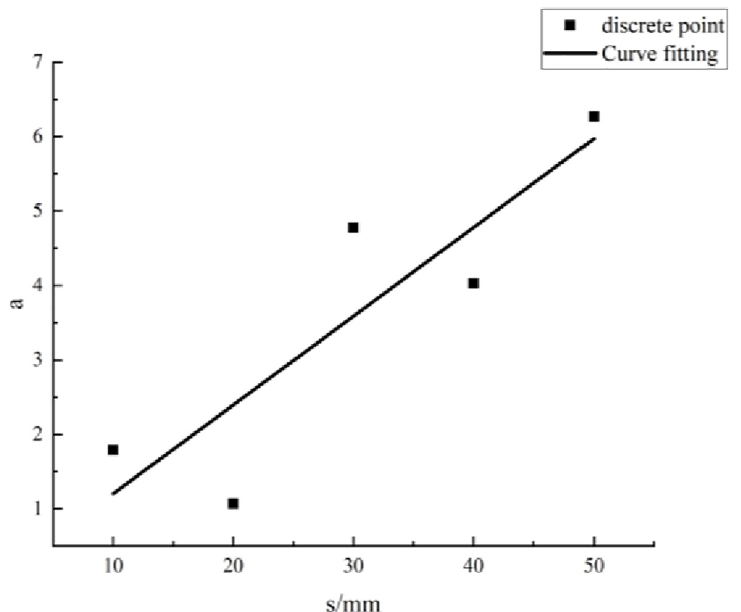
Fig 7. Fitting curve of parameter a and parallel-joint